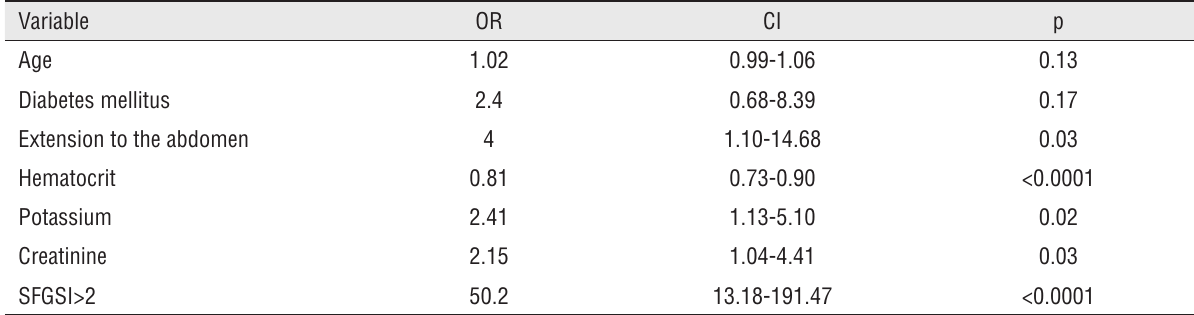
Table 3 - Independent risk factors for mortality (logistic